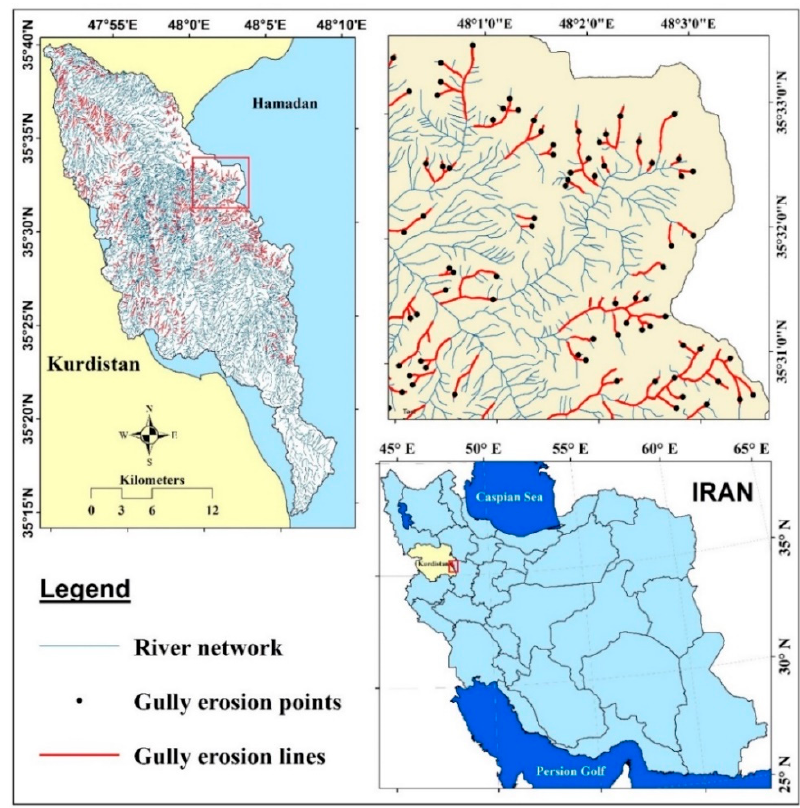
Figure 1. Location of study area and gully erosion sites in Kurdistan province and Iran.